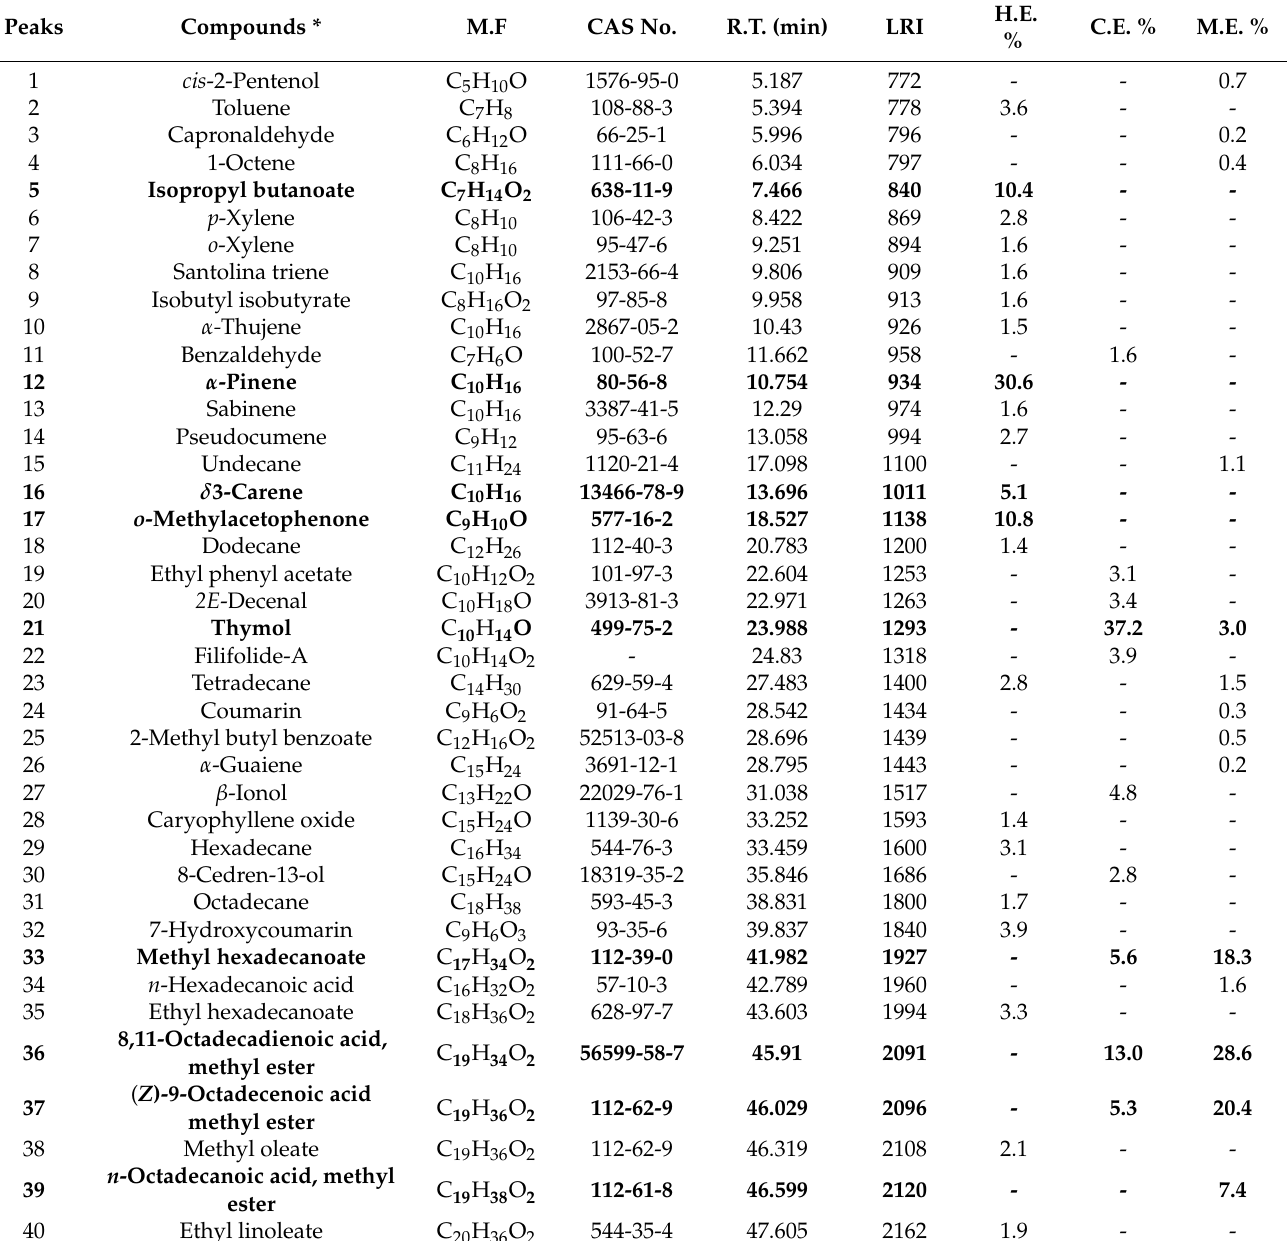
Table 1. Identified chemical constituents from various extracts of C. colocynthis seeds of Saudi